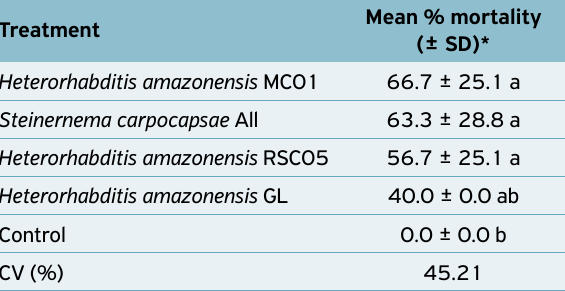
Table 1. Mortality (%) of Gryllus sp. due to the application